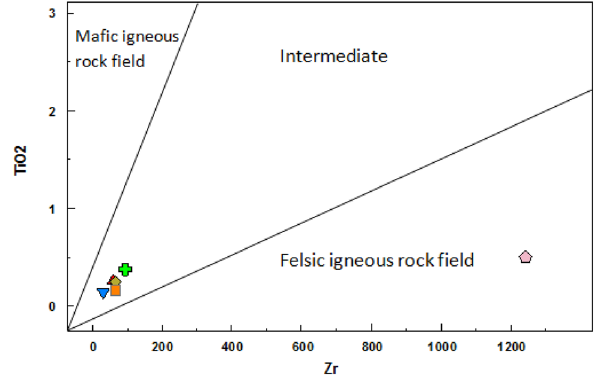
Fig. 5 Provenance diagram of TiO 2 versus Zr in study area (after Hayashi et al.